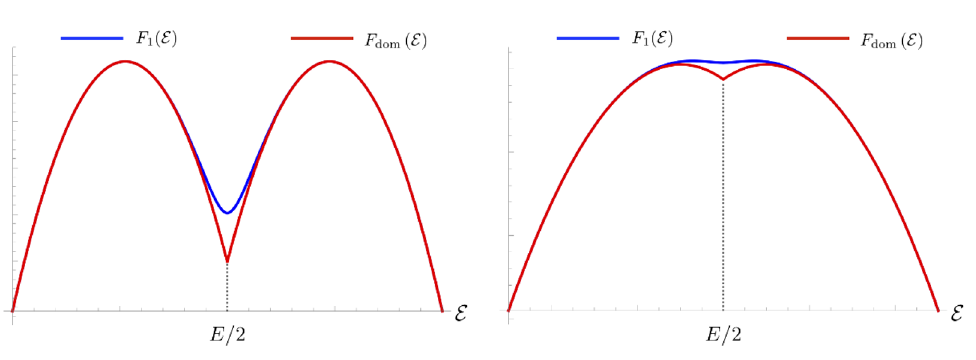
Figure 1 . F 1 ( E ) and F dom ( E ) for di(cid:11)erent regimes of Renyi index n . Left: n (cid:0) 1 (cid:29) 1 = saddle points are well separated, there is no enhanced correction; Right: n (cid:0) 1 (cid:24) 1 = points are close within the curvature scale of F 1 , an O approximate (cid:13)at interval for F 1 ( E ) emerges between the